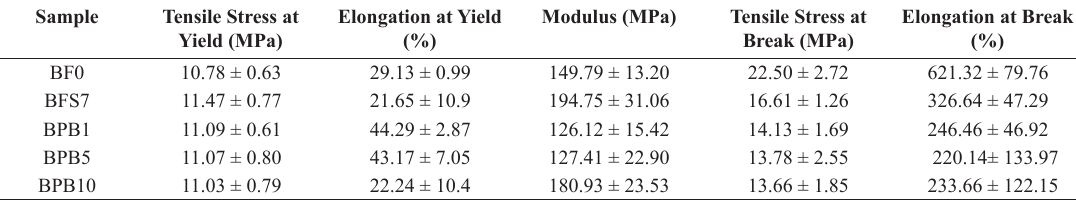
Table 4. Mechanical properties of crosslinked samples. Sample